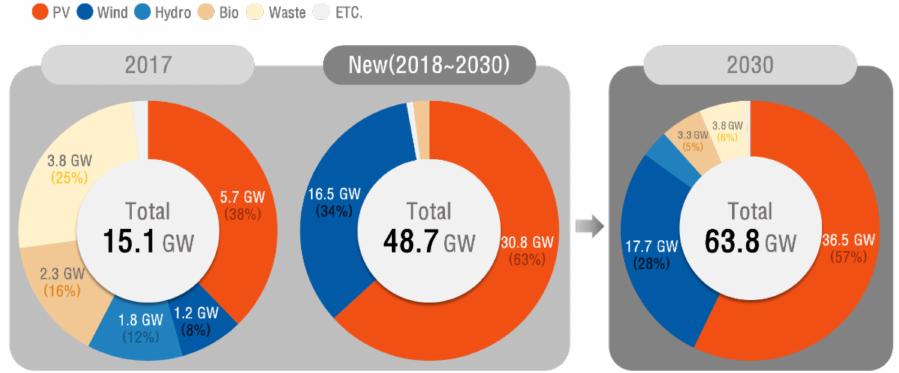
Figure 1. The renewable energy “3020” implementation plan [3].